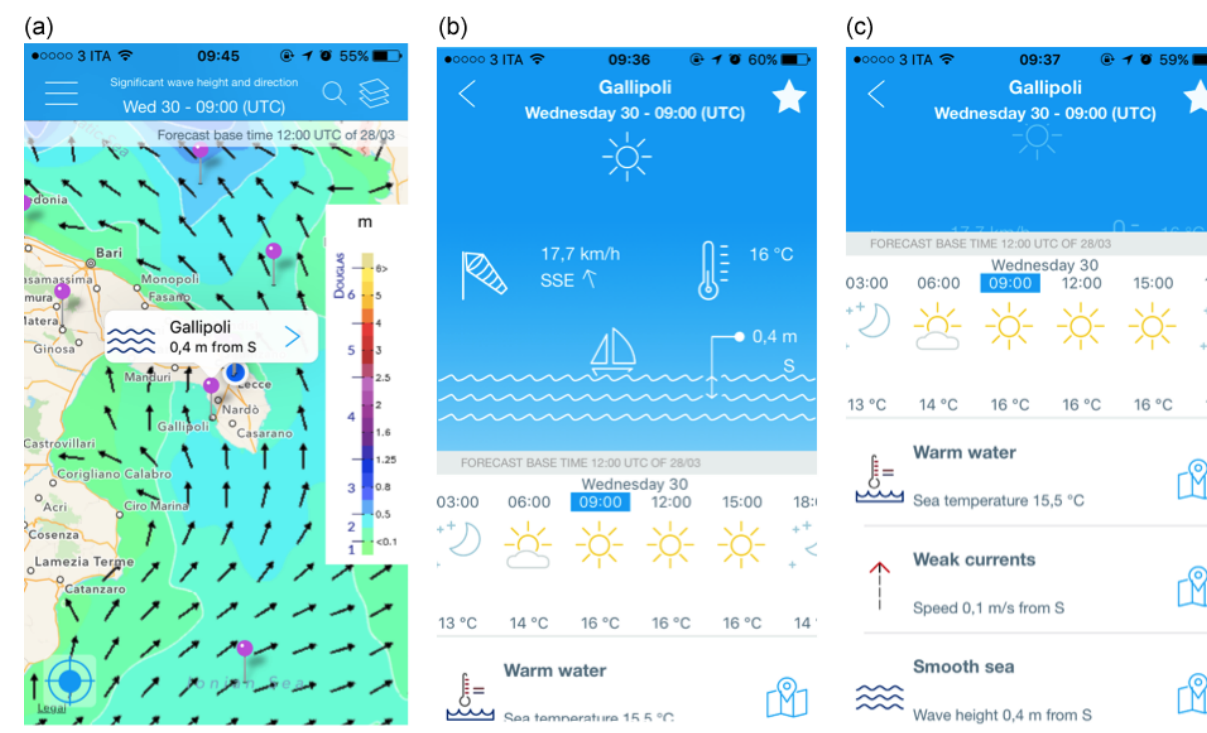
Figure 9. SeaConditions iOS mobile app – sample screens: (a) wave forecast map highlighting a sea location next to Gallipoli (40.05007 ◦ N, 17.96652 ◦ E) for which significant wave heights and directions are reported; (b) detailed bulletin for the selected location saved as a favourite place; (c) another view of the bulletin with forecast information on more environmental